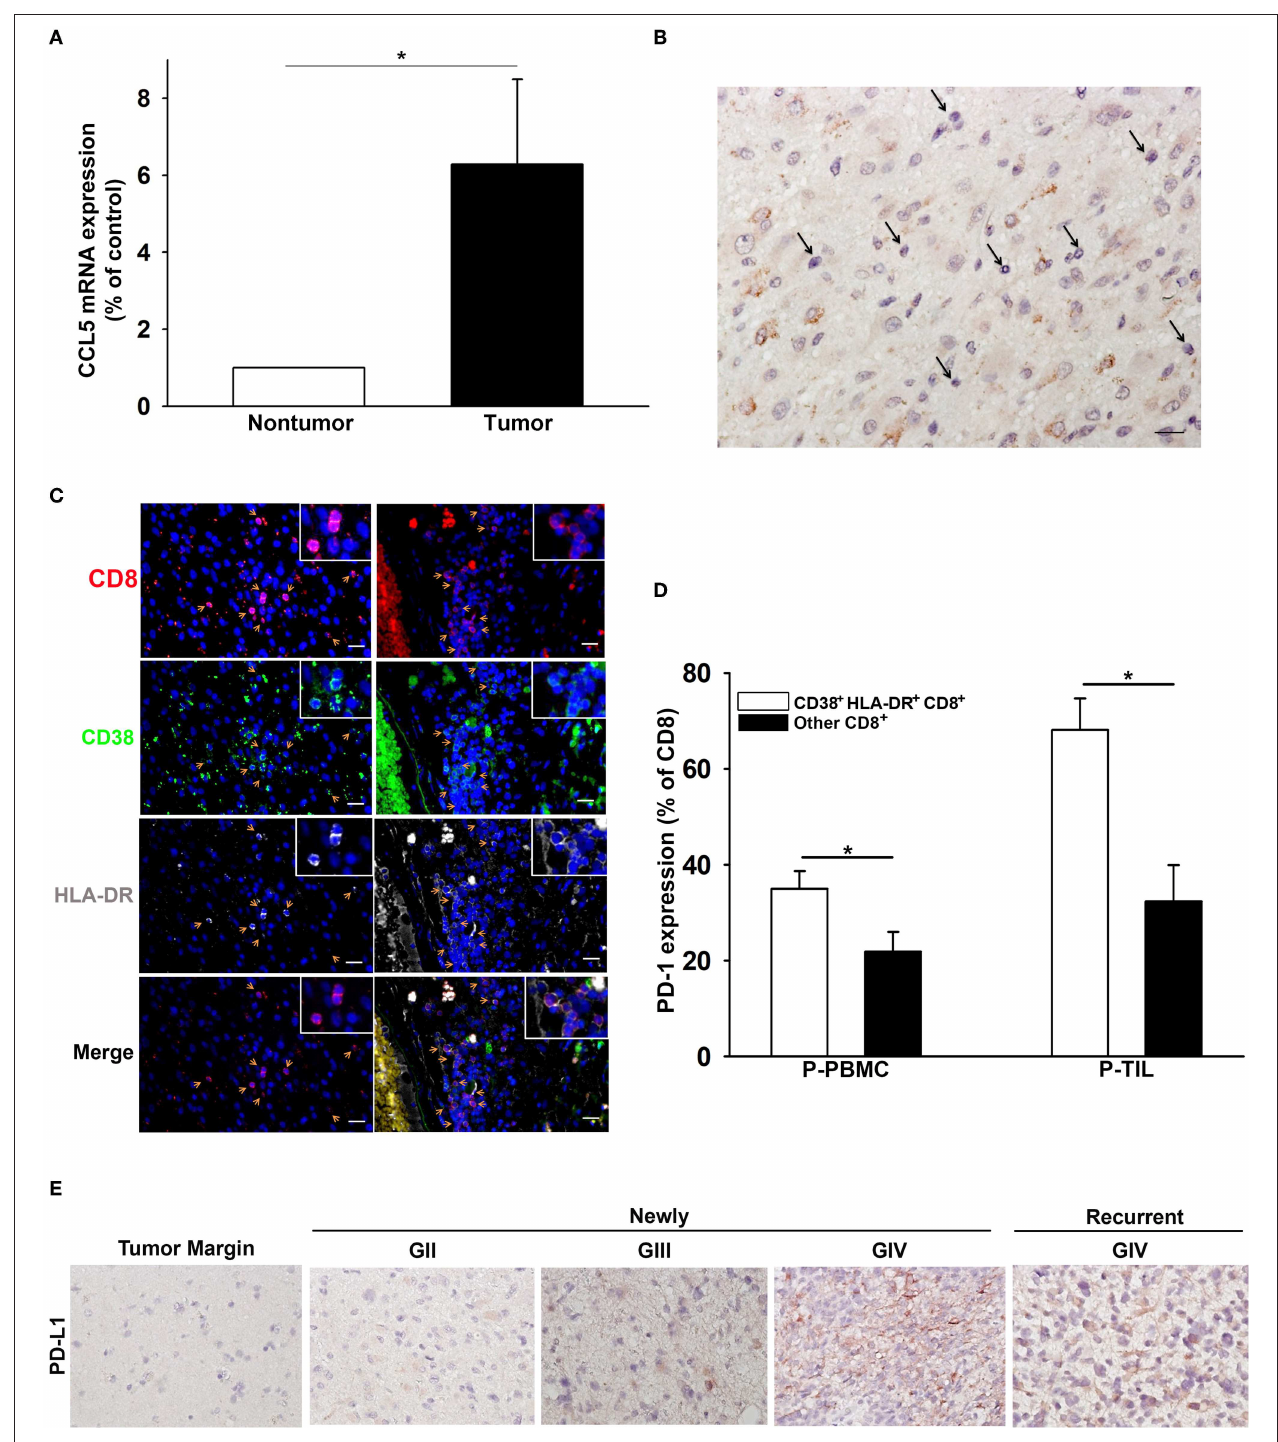
FIGURE 5 | The association of CD38 + HLA-DR + CD8 + T cell penetration and CCL5 expression in GBM. (A) Increased expression of CCL5 in gliomas (tumor; n = 15) relative to peripheral normal brain tissues (nontumor; n = 15). (B) A representative image of CCL5 (brown) expression in GBM where TILs are abundantly expressed (black arrow). (C) IHC revealed the co-expression (yellow arrow) of CD8 (red), CD38 (green), and HLA-DR (gray) in GBM (left column) and adjacent to blood vessels (right column). (D) The percentage expression of PD-1 on CD38 + HLA-DR + CD8 + T cells (white) and other CD8 + T cells (black). (E) IHC revealed the expression of PD-L1 (brown) in GII-GIV newly-diagnosed and GIV recurrent gliomas. P-PBMCs = 38; P-TILs = 17. Scale bars = 100 µ m. Values shown are means ± SEM (bars); * p < 0.05 by Student’s t- test.